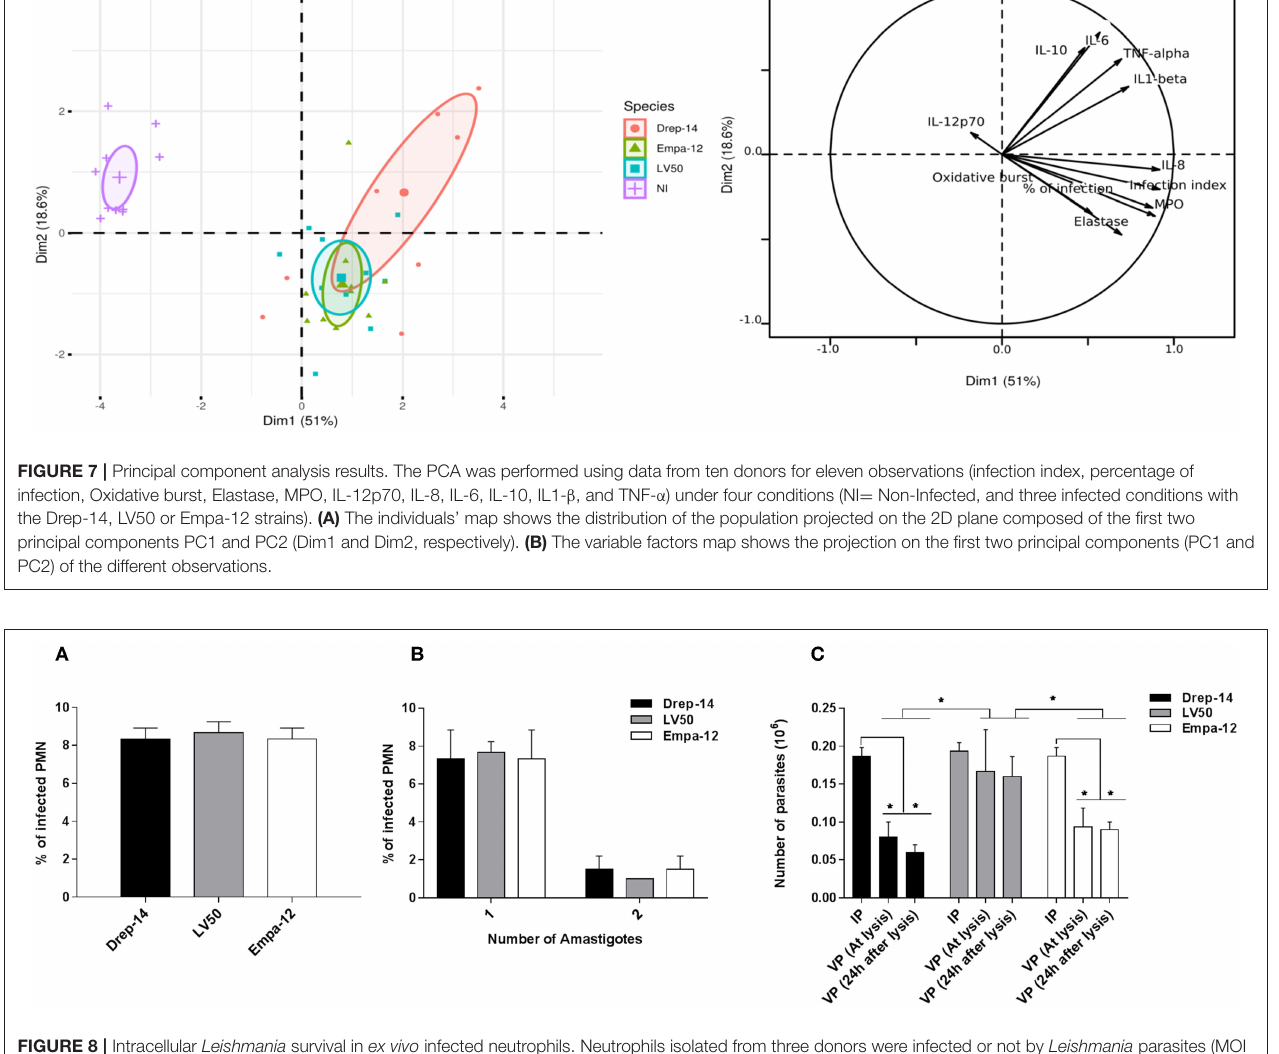
FIGURE 8 | Intracellular Leishmania survival in ex vivo infected neutrophils. Neutrophils isolated from three donors were infected or not by Leishmania parasites (MOI of 0.1) for 18h. Then, the extracellular parasites were removed and cells were fixed and stained with May-Grünwald Giemsa kit to determine, under optical microscope, the percentage of infected PMN (A) and the percentage of cells carrying the designated number of amastigotes (B) by counting at least 100 neutrophils. The PMN cultures were lysed at 18h, by 0.01 % SDS, washed with PBS and resuspended in 100 µ L Schneider medium supplemented with 10 % FBS and cultured at 22 ◦ C. (C) Parasites viability was assessed right after the lysis of the cells and 24h later by an MTT assay. Data are shown as mean values of number ± SD. We performed the non-parametric Mann–Whitney test to compare infection parameters (A,B) , and in (C) : (i) for each strain, the number of Internalized Parasites (IP) within the infected cells vs. the number of Viable Parasites (VP) after lysis at each time point, and (ii) between strains, in a pair- wise manner, the number of surviving parasites at each time point; * p < 0.05 indicates statistically significant